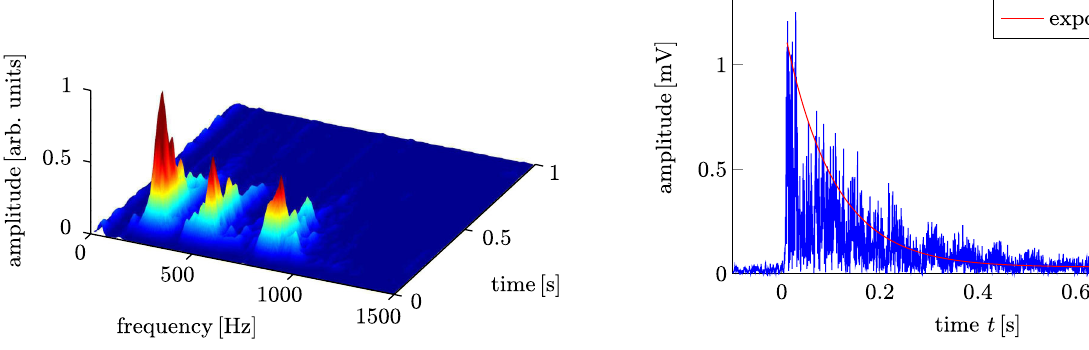
FIG. 16. Exponential decay of the OST signal amplitude (absolute value), measured over a full